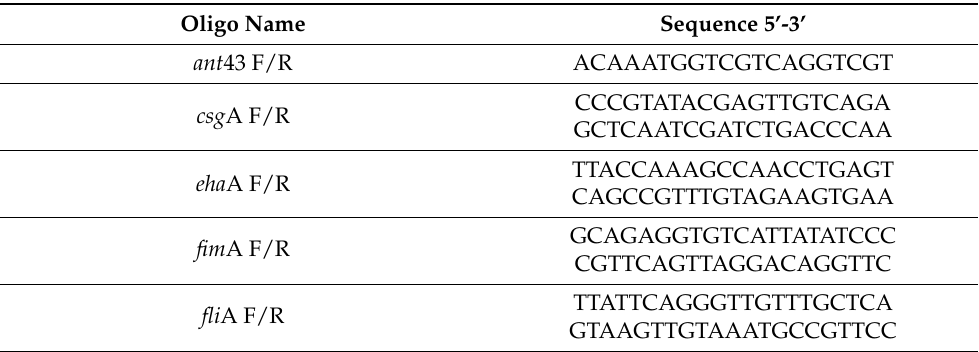
Table 3. Primers used in this study for reverse transcription-quantitative